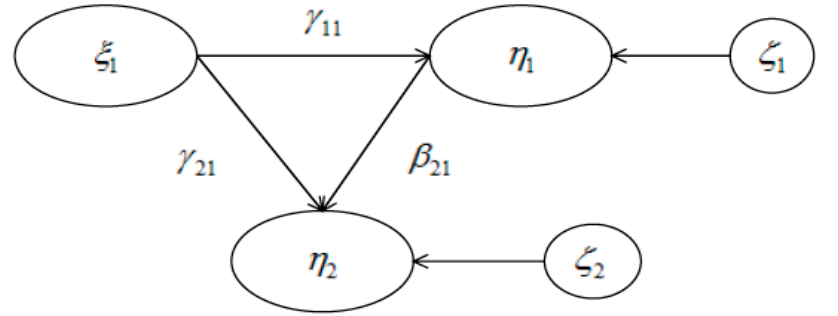
Figure 3. The structural model in structure equation modelling.